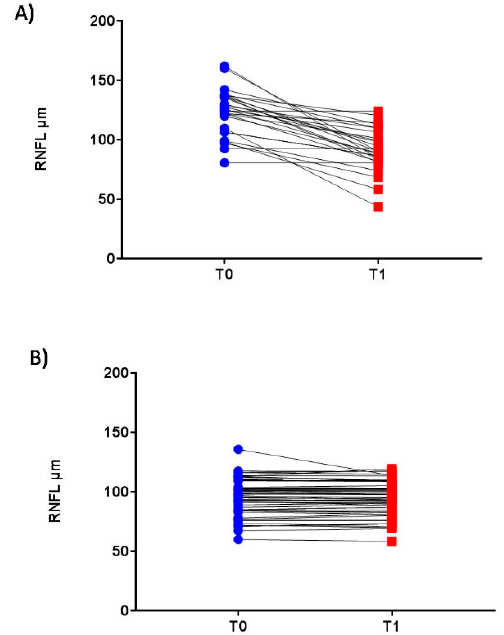
Figure 1. Longitudinal changes of the retinal nerve fiber layer in ON and nON eyes. Longitudinal changes of the retinal nerve fiber layer (RNFL) in optic neuritis (ON) and nonoptic neuritis (nON) eyes at T0 (acute phase of the relapse) and T1 (after 180 ± 2 days). ( A ) ON eye: RNFL measurement in the ON a ff ected eye decrease in the retinal thickness in ON eyes, whereas the RNFL showed an initial increase with a subsequent decline. ( B ) nON eyes: RNFL measurement in the nona ff ected eye showed a slight reduction at the follow-up. RNFL: retinal nerve fiber layer; ON: optic neuritis, nON: nonoptic neuritis, T0: acute phase of the relapse; T1: 180 ± 12 days after relapse onset. The reported data refer to the whole sample ( n = 90).